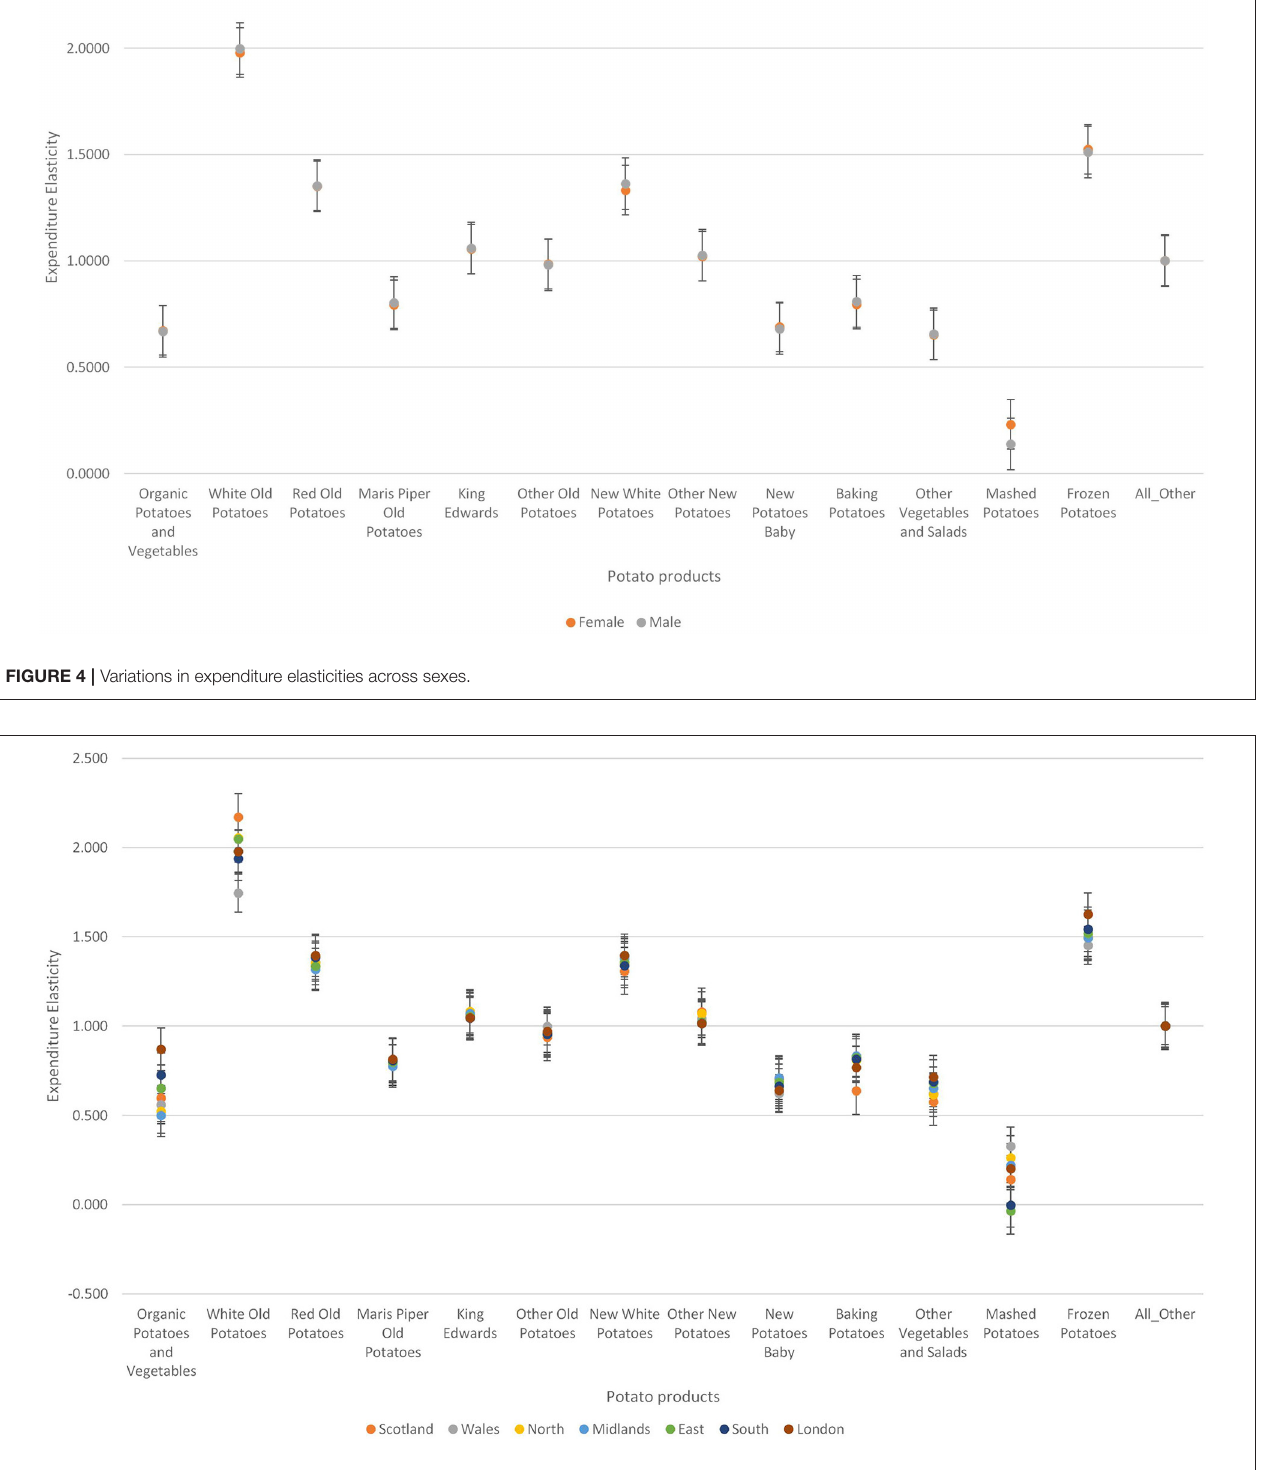
Frontiers in Nutrition |